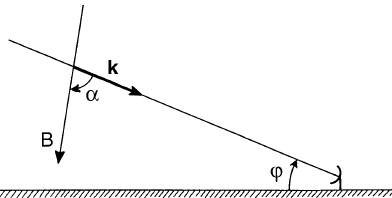
Fig. 1. Scattering geometry. (cid:117) is the antenna elevation and (cid:97) the angle between the magnetic field B and the backscatter wave vector (cid:107) . Antenna pointings and receiver filter settings are given in Table